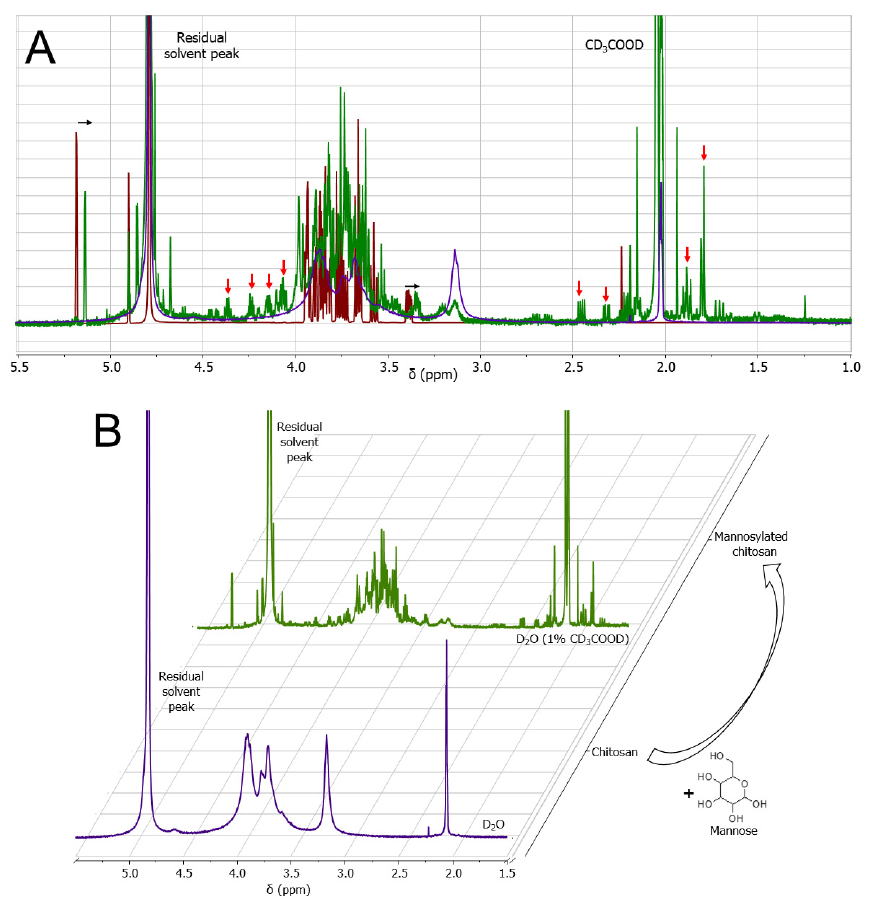
Figure 3. ( A ) Overlapped 1 H NMR spectra of chitosan (purple), mannose (red), and mannosylated chitosan (green) with highlighted changes due to mannosylation. Red and black arrows indicate new peaks and peak shifts, respectively. ( B ) Stacked chitosan and mannosylated chitosan 1 H NMR spectra showing the difference in peak broadening and presence of fine structure post-mannosylation.